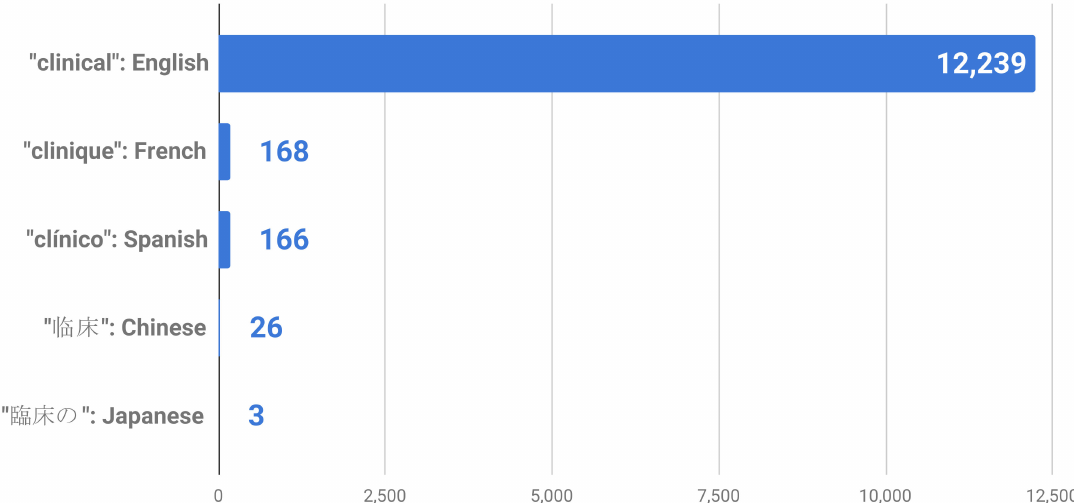
Figure 1. The number of repositories returned with the search term “clinical” in different